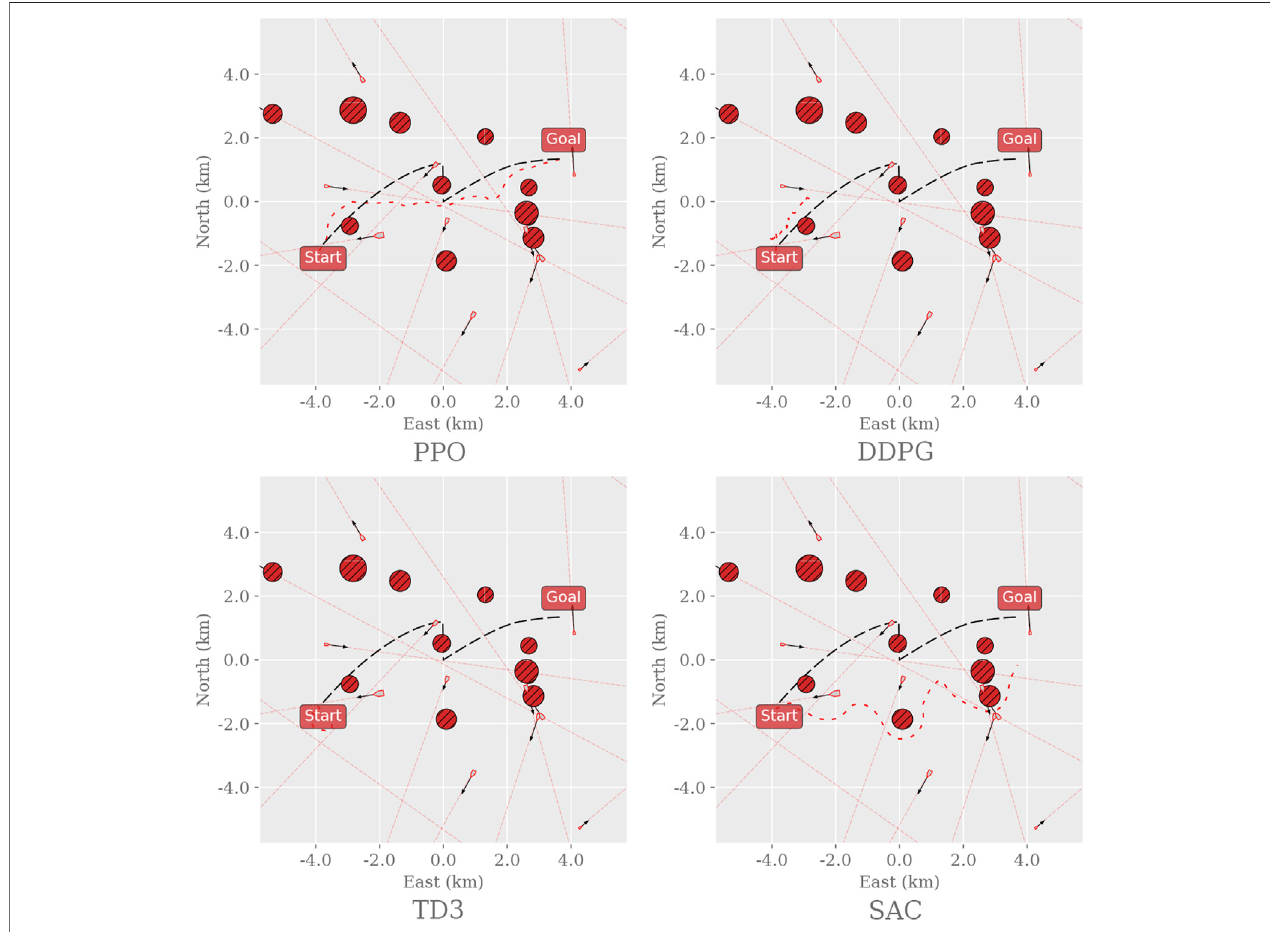
FIGURE 5 | Sample trajectories for the different RL agents in the MovingObstaclesNoRules environment. Black dashed line: path to follow; red dashed line: path taken by the vessel. The environment was generated and sampled equally for all algorithms by setting the random seed to zero and sampling the fi rst episode.